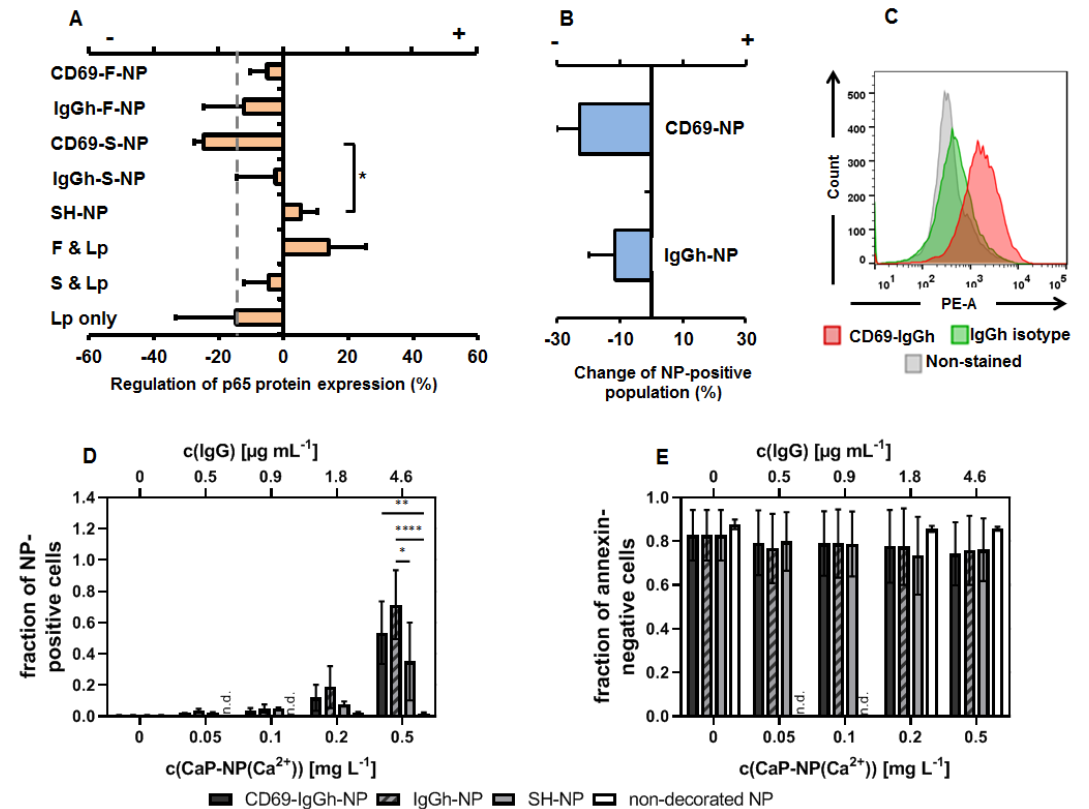
Figure 4. The potential of CD69-decorated CaP/PEI-Cy5/SiO 2 nanoparticles to down-regulate NF-kappa B p65 protein expression in murine T-cells (TK-1). ( A ) Potential of nanoparticles to down-regulate p65 together with each of their components as determined via immunoblotting, nanoparticle concentration: 1 µ g/mL siRNA. For detailed specification of nanoparticle formulations used see Tables 1 and 2. F = functional siRNA, S = scrambled siRNA, Lp = Lipofectamine TM . The regulation is the ratio of the p65 expression with respect to the inflammatory condition (CD3/CD28-stimulated cells, absence of nanoparticles) set to zero. “+ regulation” = up-regulation; “- regulation” = down-regulation. The dashed line depicts the non-inflammatory condition. ( B ) Specificity of CD69 or Fc γ R-specific-binding of the decorated nanoparticles as determined via flow cytometry (change of nanoparticle-positive cells under competition condition (non-competition condition = 0)). ( C ) Control for the expression of CD69 on T-cells surfaces as target molecule of decorated nanoparticles determined via flow cytometry. ( D ) Nanoparticle uptake. ( E ) Nanoparticle biocompatibility (annexin-negative cells). Statistical differences between control or indicated groups with * p < 0.05, ** p < 0.01, **** p < 0.0001. n.d.: not